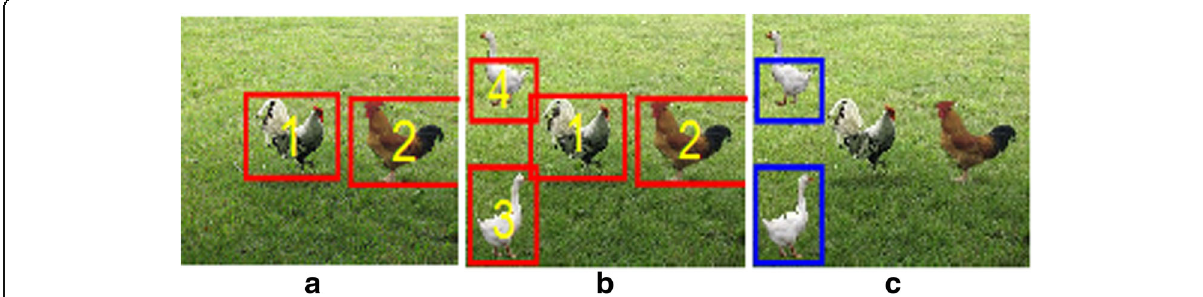
Fig. 6 Illustration of tampered localization: a an original (transmitted) image, b a received (maliciously tampered) image, and c localization of tampered region by blue rectangle